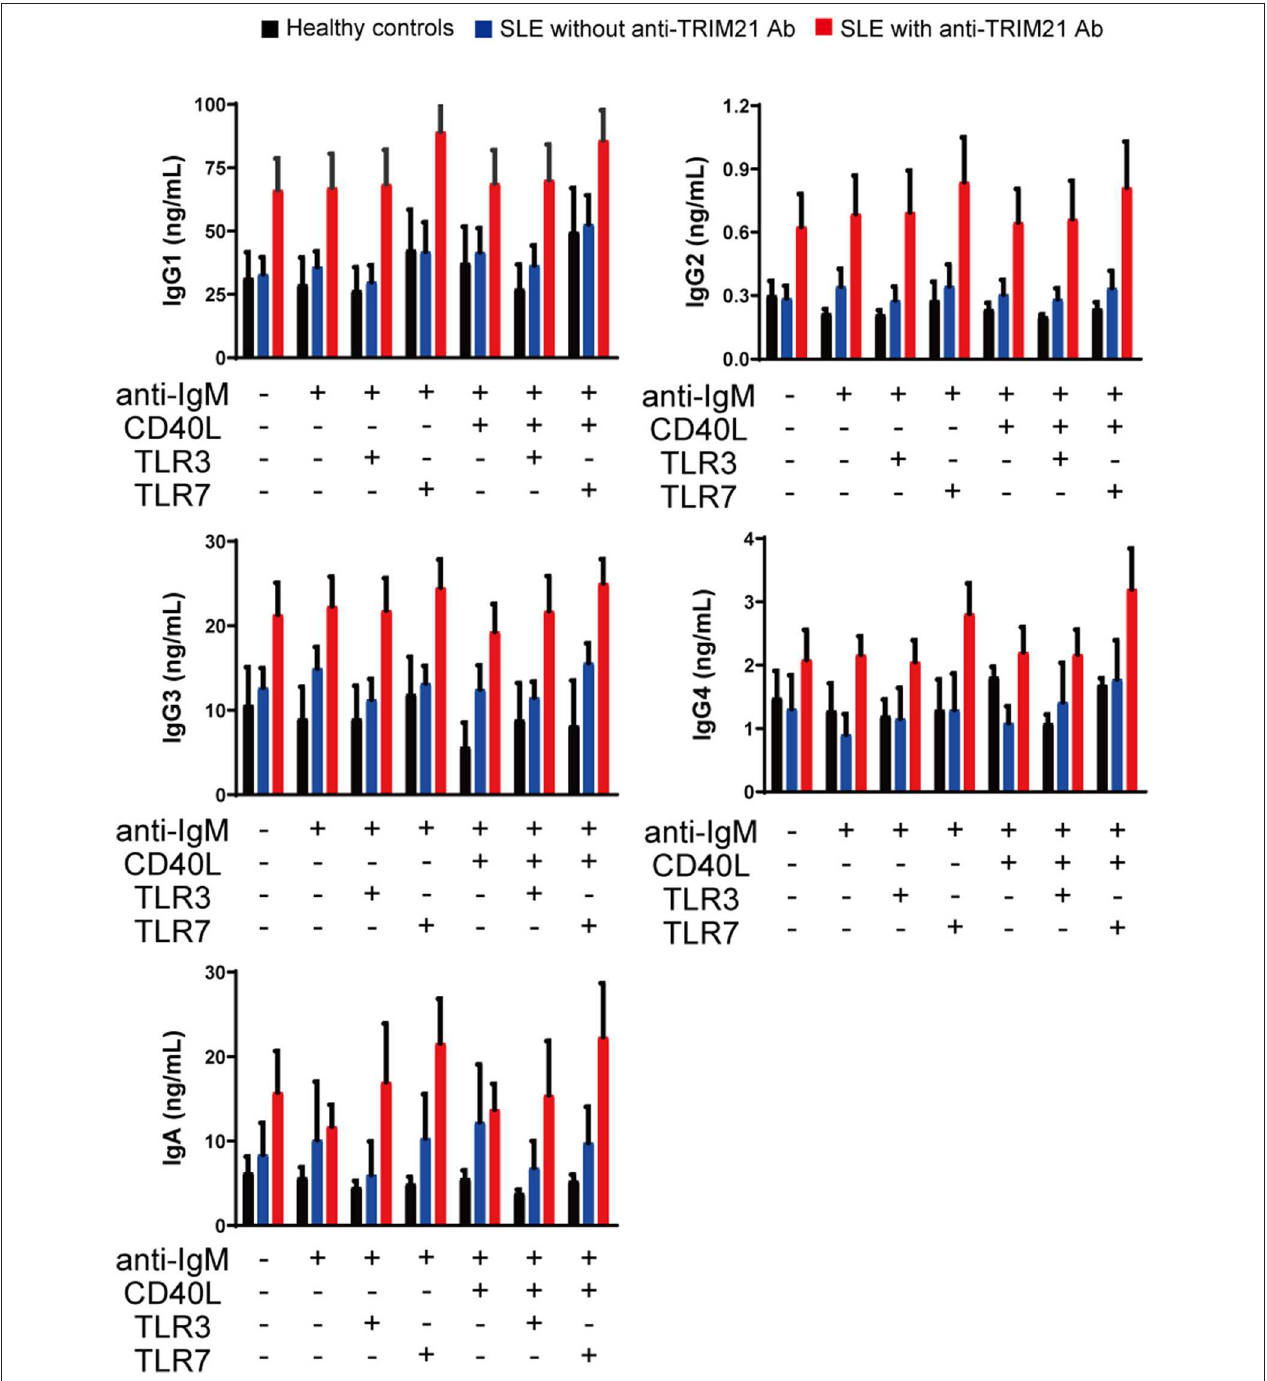
FIGURE 11 | The immunoglobulin productivity in patients with SLE. Concentrations of IgG1, IgG2, IgG3, IgG4, IgA, and IgM in culture supernatants of human resting B cells stimulated with anti-IgM Ab, CD40L and/or TLR3/7 ligands were measured by multiple soluble analyte immunoassays (healthy controls; n = 5, SLE patients without anti-TRIM21 Ab; n = 11 and SLE patients with anti-TRIM21 Ab; n = 6). Values are shown as means ± SEM.